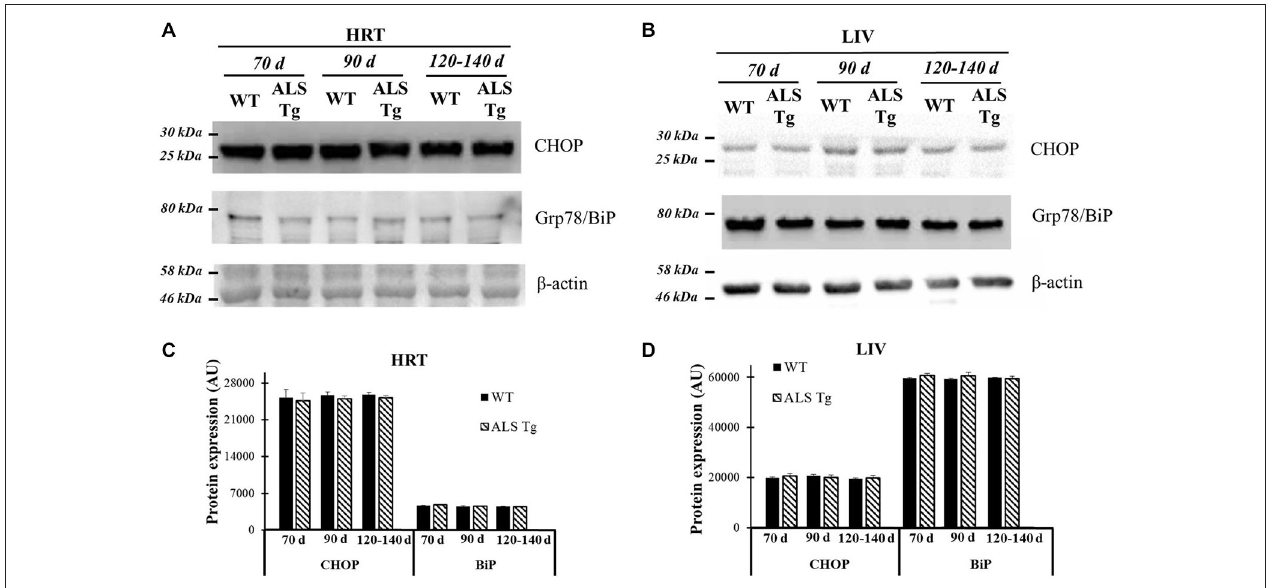
pre-symptomatic (90d; n = 5 each for WT and ALS-Tg), and symptomatic (120–140d; n = 3 each for WT and ALS-Tg) mice. (B) Liver tissues (LIV) was collected and protein levels were determined as described above. Analysis of average arbitrary units (AU) obtained by densitometry of Grp78/BiP and CHOP in HRT (C) and in LIV (D) . Data in (C,D) are presented as mean ±